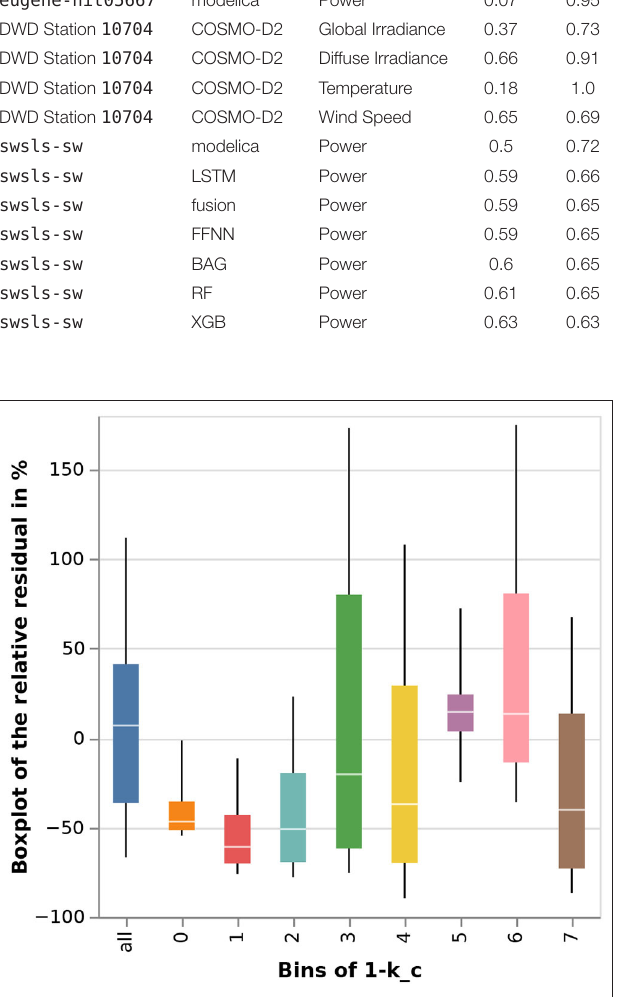
FIGURE 9 | Forecast performance of the physics-based model in terms of the relative residual; overall and per bin of 1